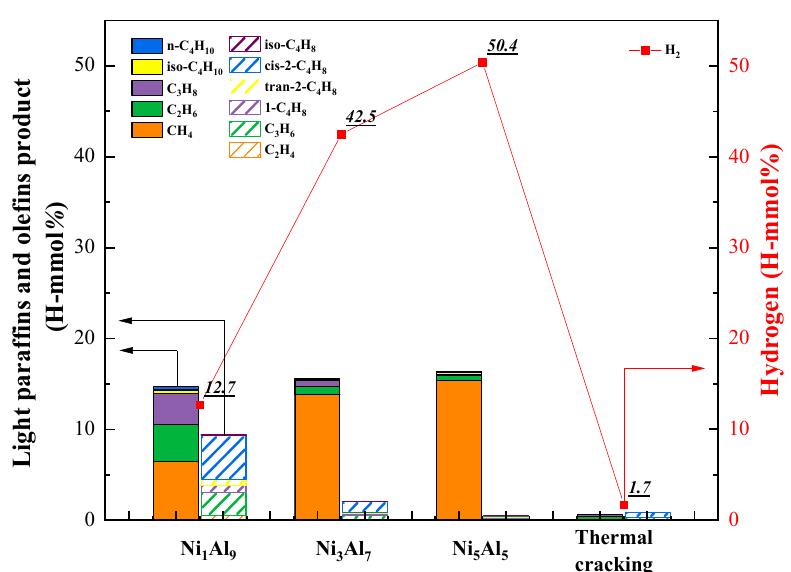
Figure 7. Gaseous product distributions at 450 °C and 4 MPa.